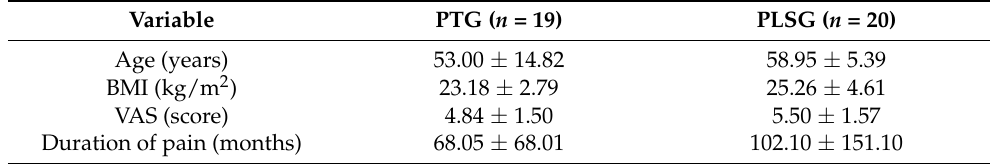
Table 1. Characteristics of the